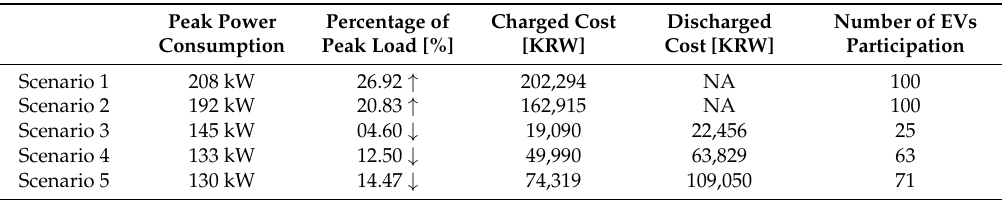
Table 7. Comparison of simulation